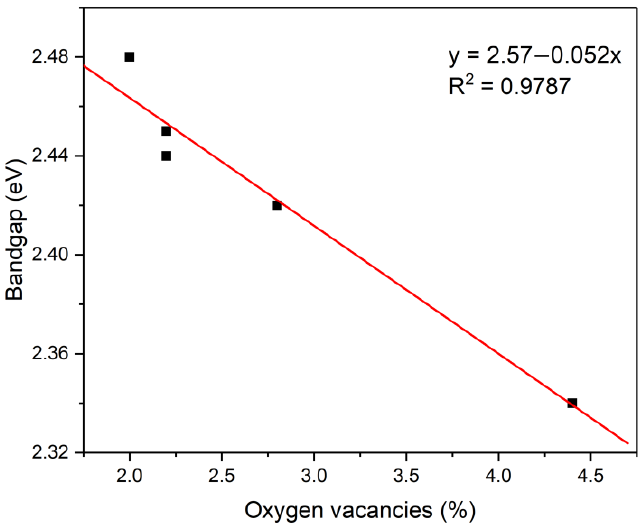
Figure 7. Correlation between bandgap and oxygen vacancies of the samples.